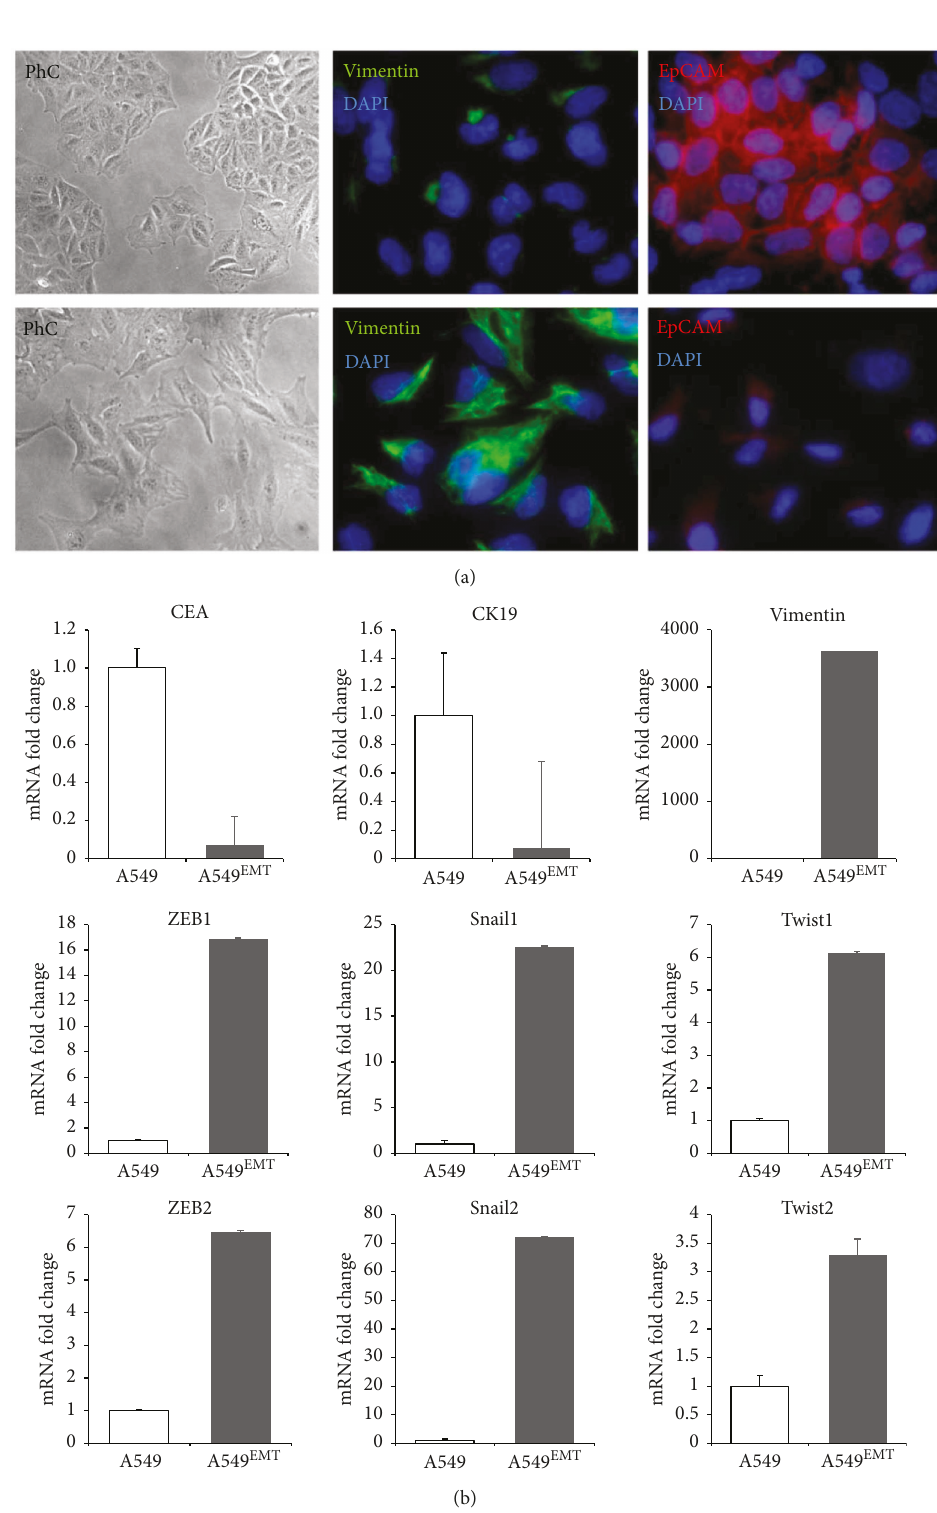
Figure 2: Representative micrographs showing the assessment of TGF- β 1-mediated EMT in A549 cells. (a) The morphological analysis by di ff erential interference contrast microscopy of the A549 cells exposed to TGF- β 1 shows the acquisition of an elongated morphology with reduction of intercellular contacts compatible with EMT-like compared to unexposed A549 cells. (b) The immuno fl uorescence analysis reveals a dramatic reduction of EpCAM-positive cells (red fl uorescence) in A549 cells exposed to TGF- β 1 as compared to unexposed cells which retain the typical bordered staining. Furthermore, the A549 TGF- β 1-treated cells showed a strong intracytoplasmic positivity for